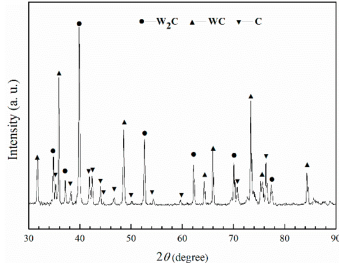
Figure 1. X-ray diffraction pattern of the as-received WC particles indicating that the particles were composed of W 2 C, WC and free carbon